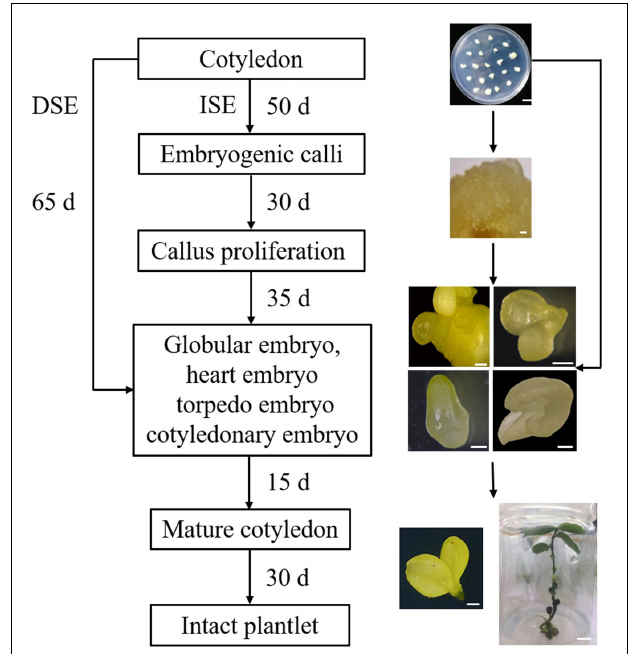
FIGURE 7 | Flow chart for direct and indirect somatic embryogenesis regeneration system in C. oleifera .